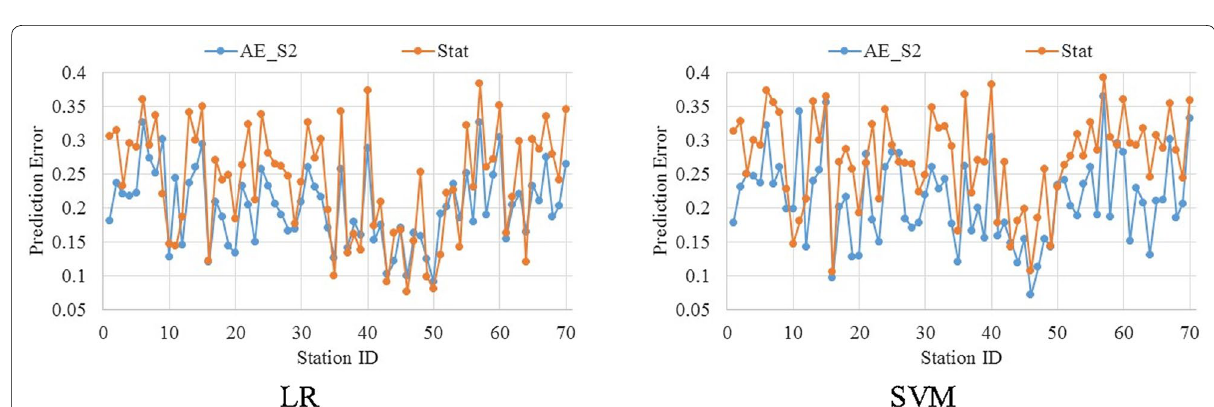
Fig. 7 Comparison of day-ahead prediction error between SAE stage 2 and stat features. Table 3 in appendix details the empirical